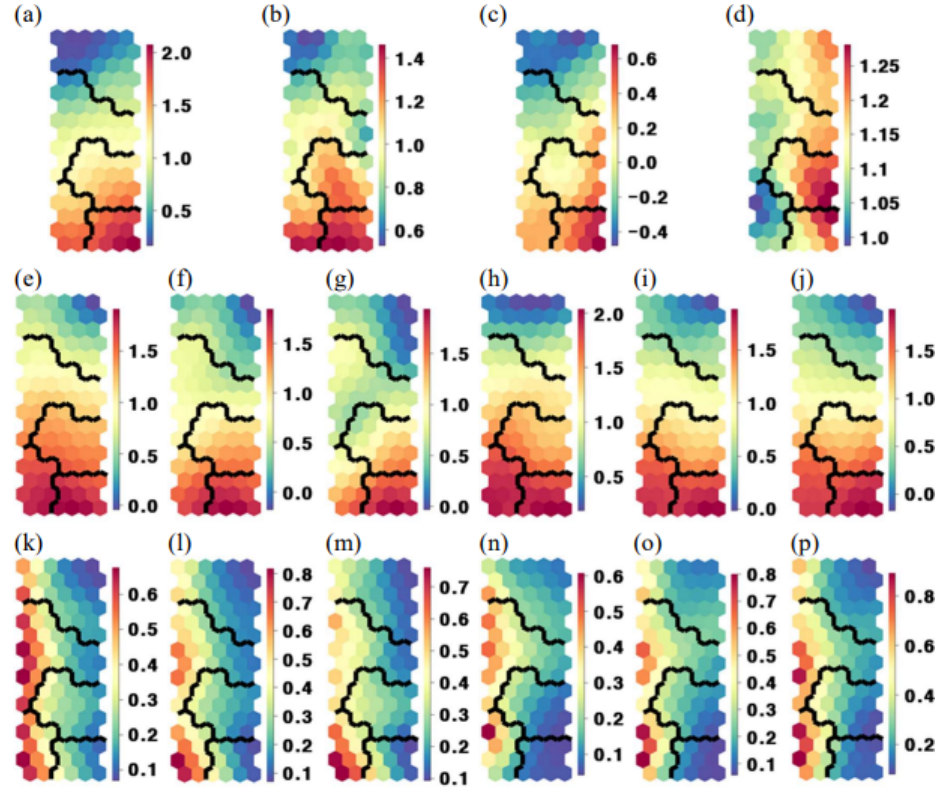
Figure 6. (a–p) Component planes of variable weightings for rainfall amount (AMO) (a) ; rainfall duration (DUR) (b) ; rainfall intensity (INT) (c) ; antecedent soil moisture (ASM) (d) ; soil moisture difference indices for the upslope and downslope at depths of 10, 30, and 60cm (VUP10, VUP30, VUP60, VDO10, VDO30, and VDO60) (e–j) ; standard deviation of peak time for the upslope and downslope at depths of 10, 30, and 60cm (SUP10, SUP30, SUP60, SDO10, SDO30, and SDO60) (k–p)